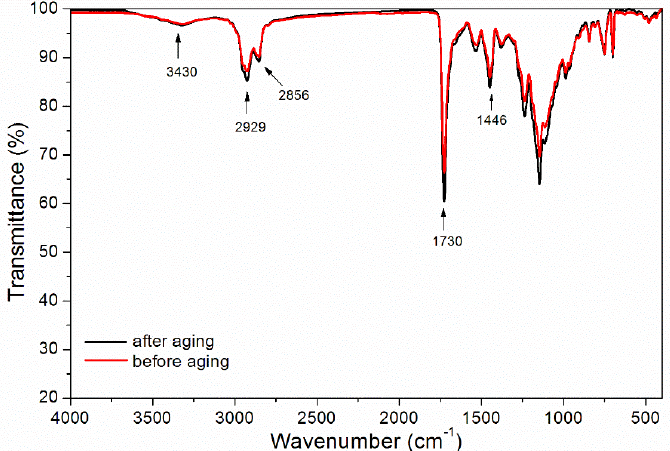
Figure 8. Infrared spectra of waterborne wood coatings with 3.0% glass fiber powder before and after aging.